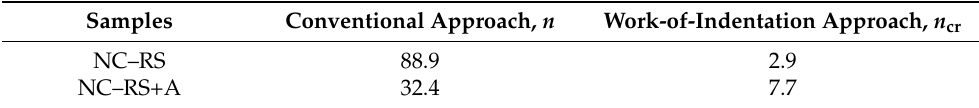
Table 2. Comparison between creep stress exponents obtained via conventional and work-of